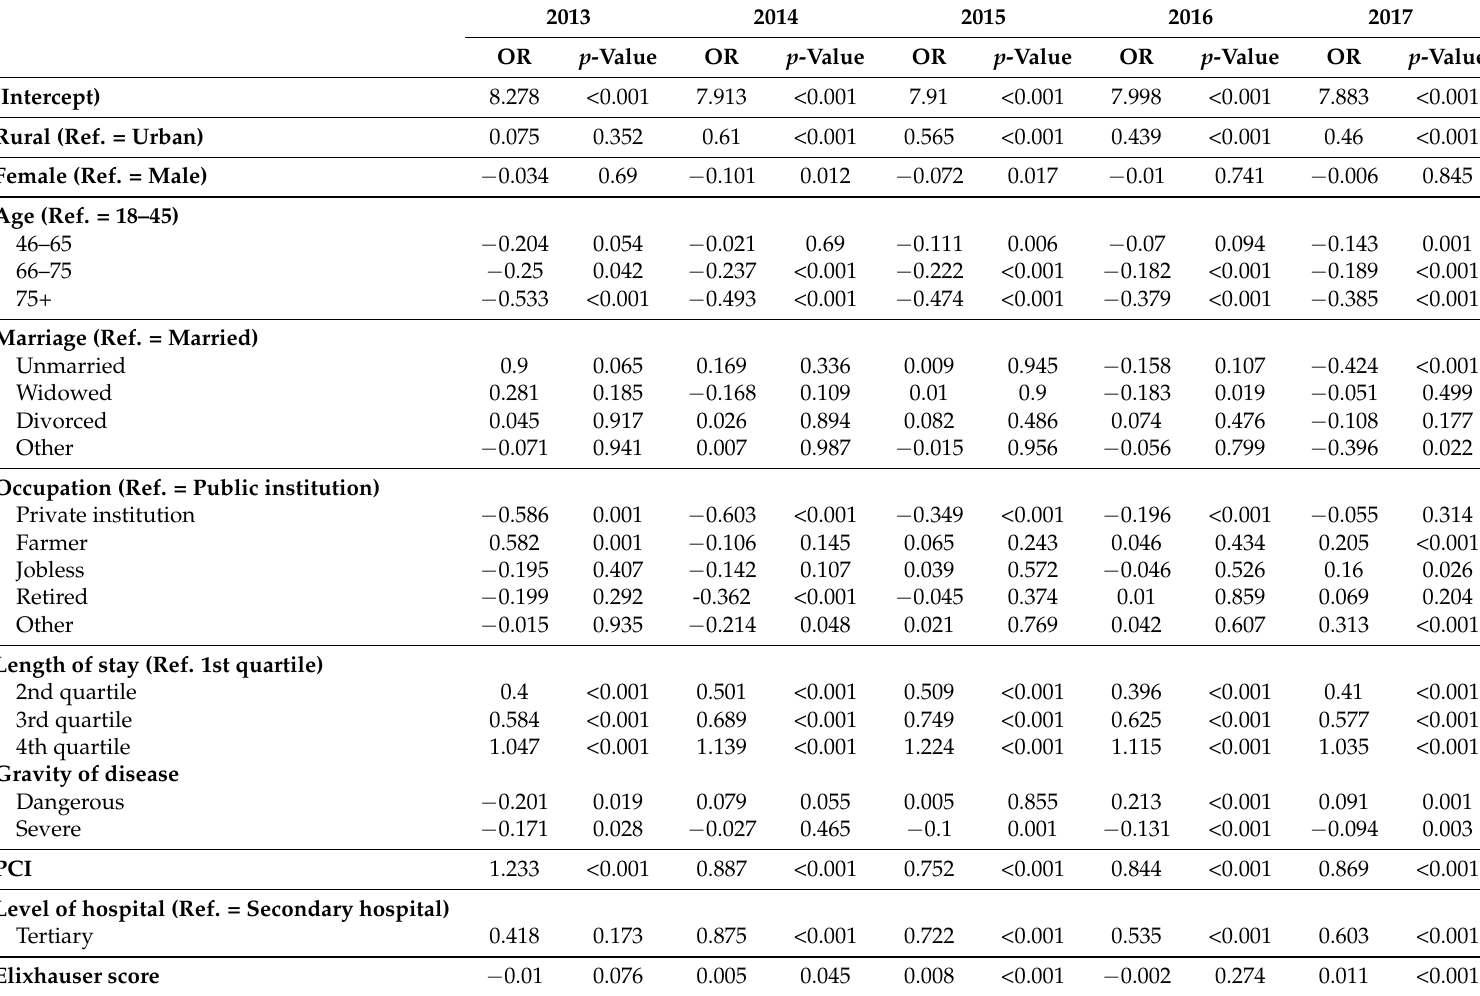
Table 4. Log-linear model results for non-zero OOP expenses,